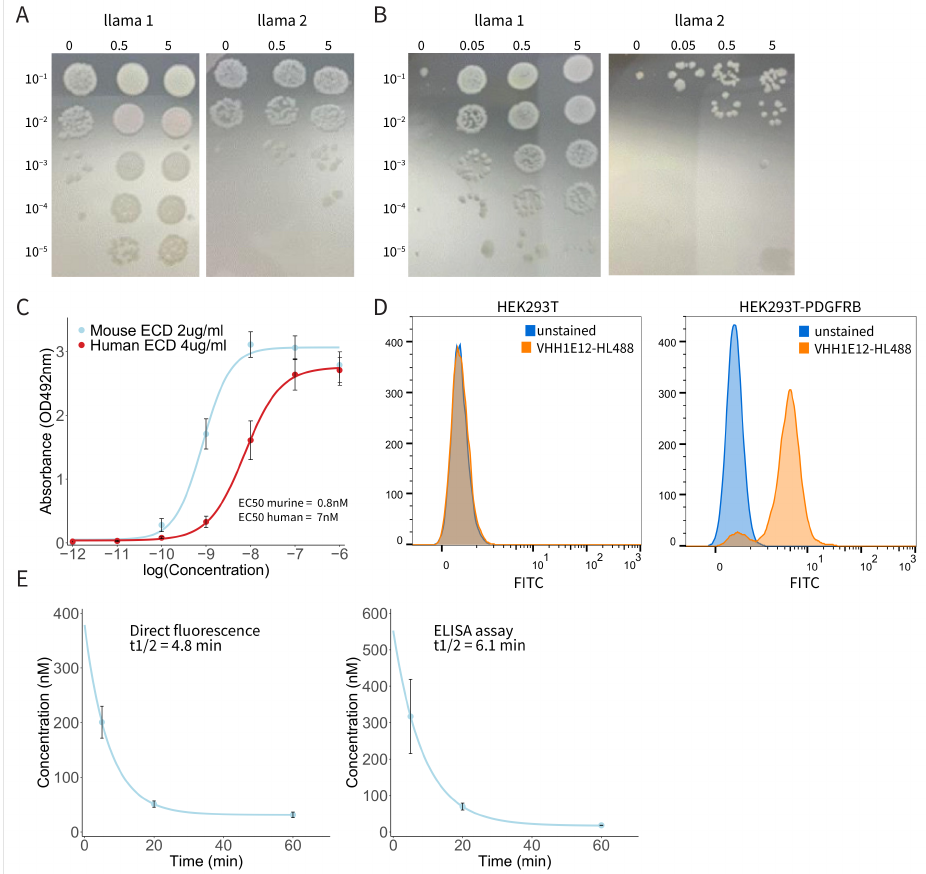
Figure 3. PDGFRB-binding nanobody VHH1E12 binds with nanomolar affinity to human and murine PDGFRB. ( A ) First round of phage selection. Precipitated phages were applied to wells coated with a range of PDGFRB concentrations. Outputs of the binding phages from wells coated with 5 µ g/mL of PDGFRB were eluted and used to infect new TG1 cultures. ( B ) Second round of phage selection. Outputs of phages binding to wells coated with 0.05 µ g/mL of PDGFRB were eluted from the wells and used to infect new TG1 cultures. Outputs from the first and second round of phage selections were cultured for single clone picking, after which monoclonal VHHs were selected for further analysis. ( C ) Dose–response curve of biotin labelled VVH1E12 binding to human and murine Extra Cellular Domain (ECD) of PDGFRB. Mean absorbance with SEM is shown from four independent experiments. EC50 human PDGFRB = 7 nM; EC50 murine PDGFRB = 0.8 nM. ( D ) Dose response of HighLight488-conjugated VHH1E12 to HEK293T-PDGFRB cells. The left graph shows the percentage of cells positive for VHH1E12 and the right graph shows the MFI. ( E ) Pharmacokinetic analysis of IRDye800cw labelled VHH1E12. Plasma levels were assessed by direct fluorescence measurement (left graph) and using an anti-VHH secondary antibody and ELISA assay (right graph). Mean of three animals with SEM is